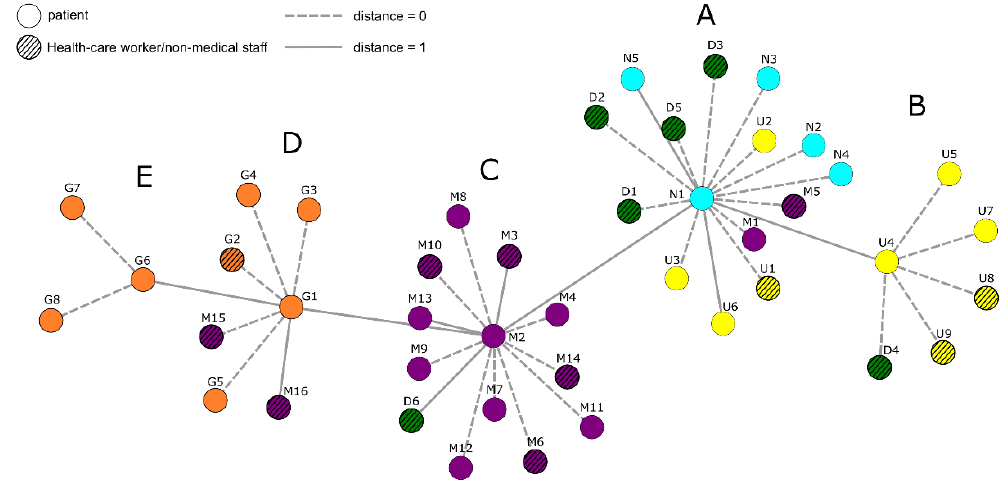
Figure 1. Genomic surveillance of SARS-CoV-2 hospital outbreak with the ∆ 168 variant across multiple wards. Genetic distances were determined by computing the minimum spanning tree from pairwise edit distances between 44 complete SARS-CoV-2 sequences stemming from the hospital outbreak. Edit distances of zero or one are drawn by dashed or solid lines, respectively. Virus genomes isolated from patients and HCWs/non-medical staff are displayed as circles and were assigned a color corresponding to the clinical ward. HCWs/non-medical staff are shown with a broadly outlined circle and black crosslines, patients are shown with a thin outline. For each of the clusters of closely related sequences A , B , C , D and E , samples taken earliest are displayed at the center. Distances were calculated using the Edlib aligner [18], the minimum-spanning tree was computed using the Python library NetworkX [19] and visualized using Cytoscape